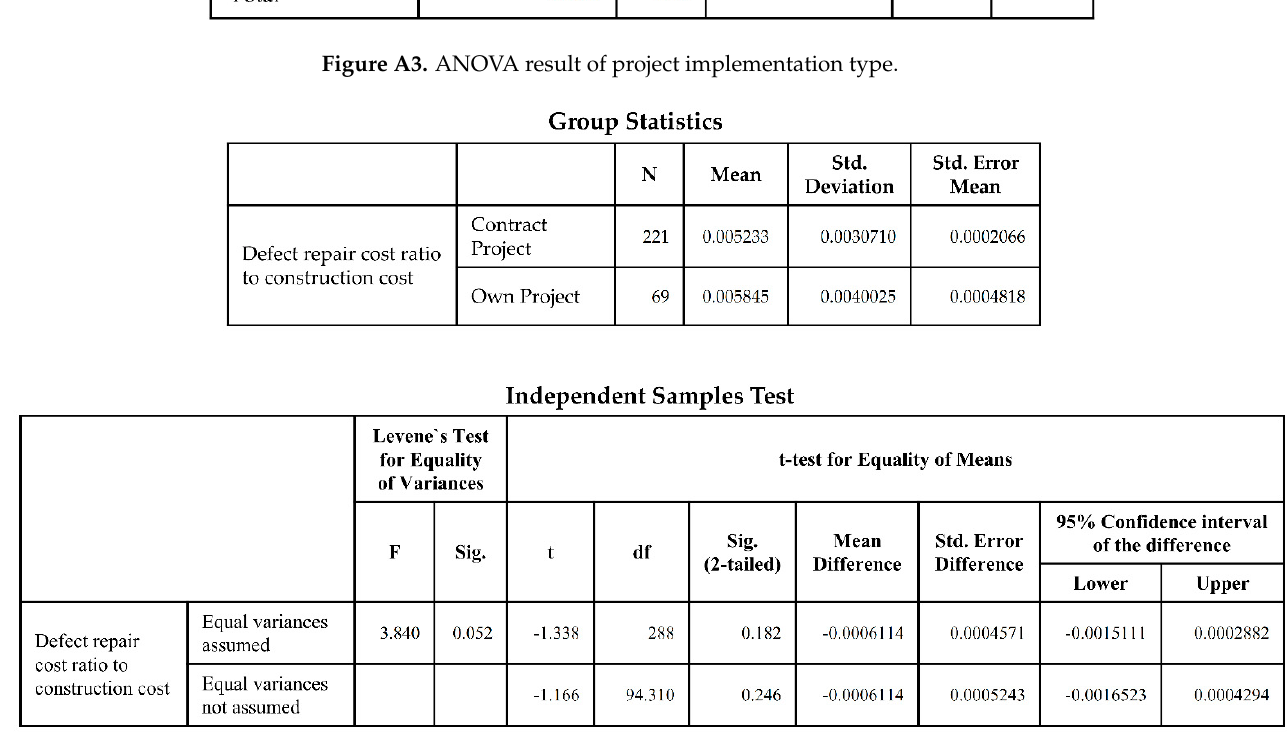
Figure A4. t -test result of building Figure A4. t ‐ test result of building execution. Figure A4. t ‐ test result of building execution.